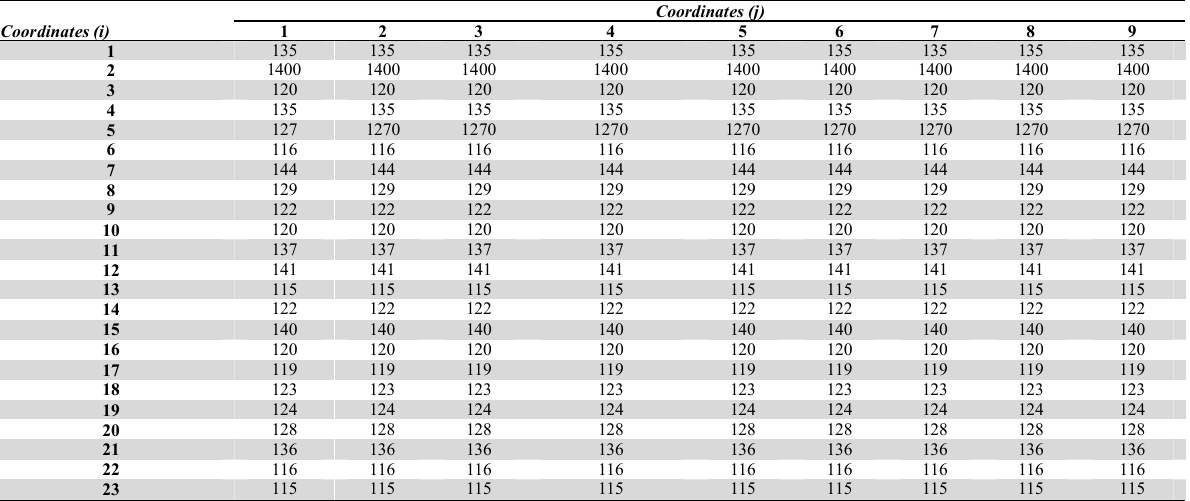
Yearly set-up cost for local bases (×10 6